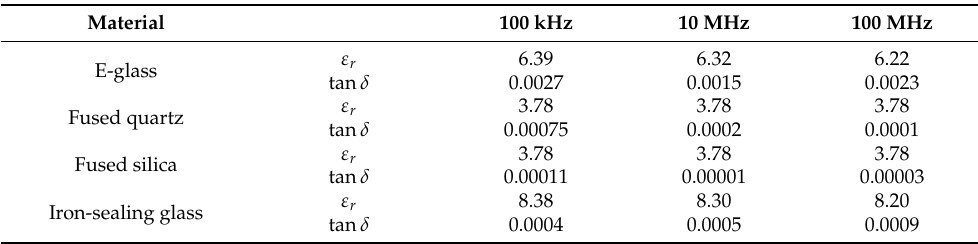
Table 2. The relative permittivity ( ε r ) and loss tangent (tan δ ) for different materials of a glass test tube at various frequencies (at 20 ◦ C)